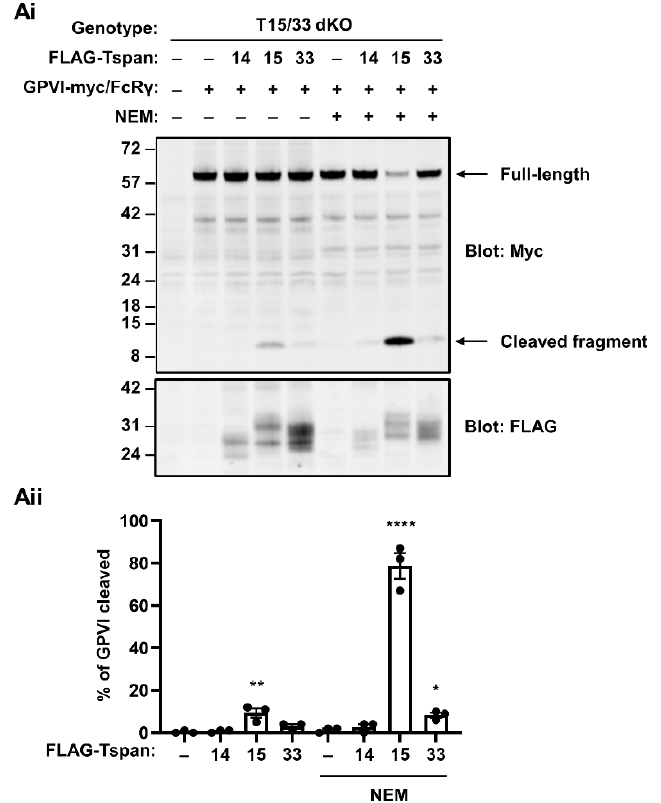
Figure 3. Tspan15/ADAM10 is the most efficient scissor for GPVI in HEK-293T cells. ( Ai ) Tspan15/33 double knockout (T15/33 dKO) HEK-293T cells were transfected with expression constructs for C- terminally Myc-tagged human GPVI and FcR γ (+) or empty vector (–), and FLAG-tagged human Tspan14, Tspan15, Tspan33 or empty vector control (–). Cells were treated with 2 mM NEM (+), or vehicle control (–) for 30 min prior to harvest, and then lysed in 1% Triton X-100 followed by anti-Myc and anti-FLAG Western blotting. ( Aii ) The percentage of cleaved GPVI from Ai was calculated. Error bars represent the standard error of the mean from three independent experiments. Data were arcsine-transformed and statistically analyzed using a two-way ANOVA followed by a Dunnett’s multiple comparison test, compared to their respective non-transfected controls in each stimulation condition (*, p < 0.05, **, p < 0.01; ****, p < 0.0001).